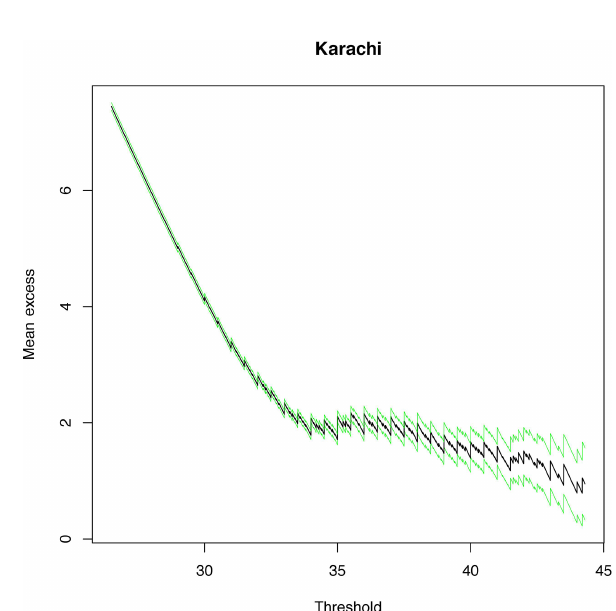
Figure 3. Mean residual life plot of the station-observed T max ( ◦ C) at Karachi.